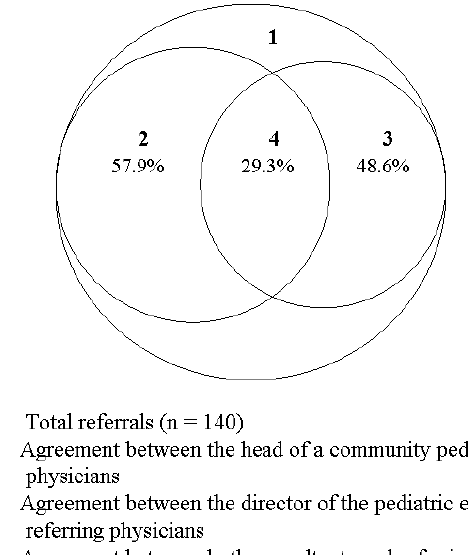
FIGURE 1. Agreement between referring physicians and consultants regarding criteria for urgency of